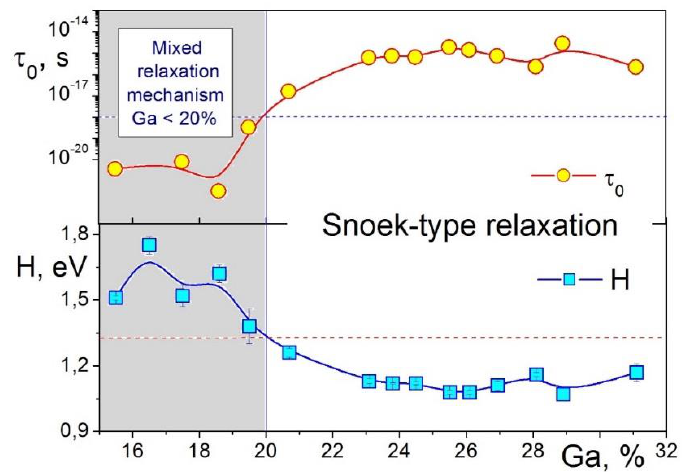
Figure 22. The relaxation time (upper) and the activation energy (lower raw) for the P1 thermally activated peak as a function of Ga content in binary Fe–Ga alloys.